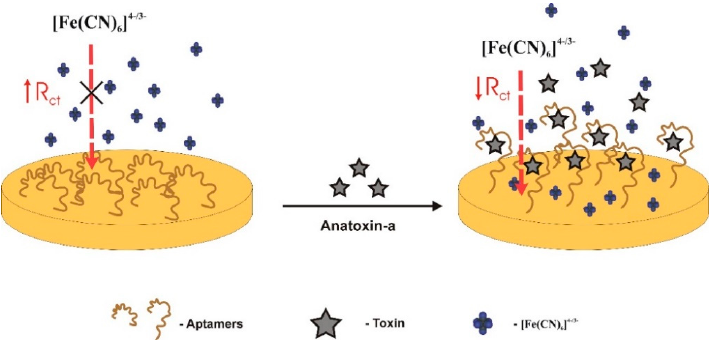
Figure 2. The mode of action of this impedance aptasensor is based on the decrease of electron resistance when aptamers change from a random conformation to a compact conformation in the presence of anatoxin-a [31]. R ct : charge-transfer resistance. presence of anatoxin-a [31]. R ct : charge-transfer